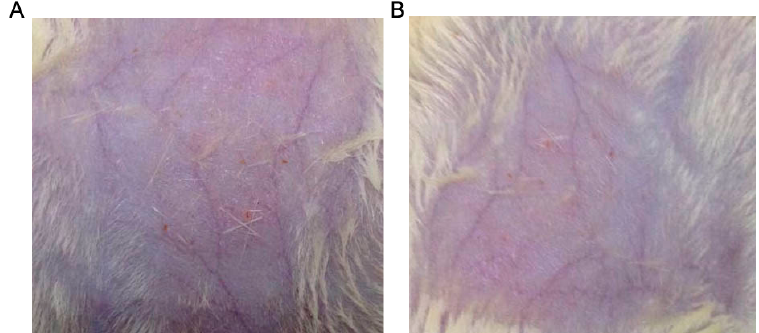
Figure 7. Irritation of nano-TiO 2 ointment on the skin of rats. Accessory ( A ) and ointment with 15% nano-TiO 2 ( B ) was rubbed on the skin of rats for month.